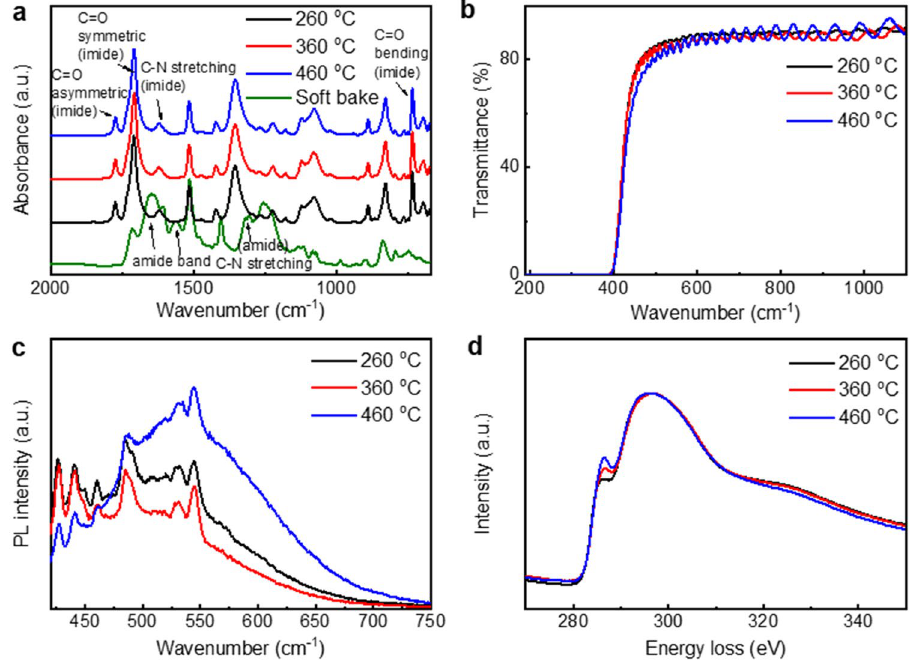
Figure 1. Characterization of polyimide materials by curing temperature. ( a ) FT-IR spectra of soft-baked PAA at 80 °C and cured PI at different temperatures. ( b ) UV–vis spectra, ( c ) PL spectra excited at 400 nm, and ( d ) EELS spectra of PI depending on curing